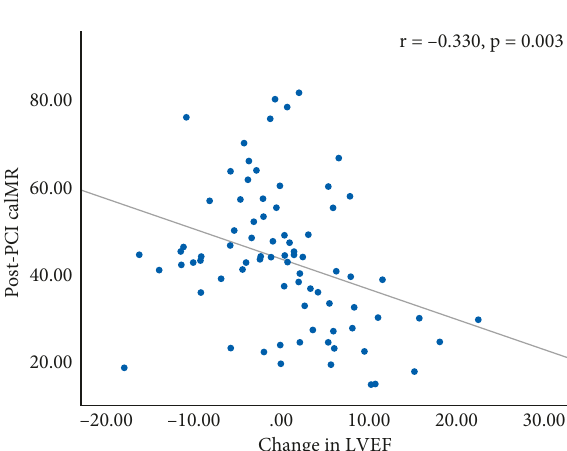
Figure 2: A significant inverse correlation found between coronary angiography-derived index of microcirculatory resistance after primary percutaneous coronary intervention and the change in left ventricular ejection fraction ( r �− 0.330, p �